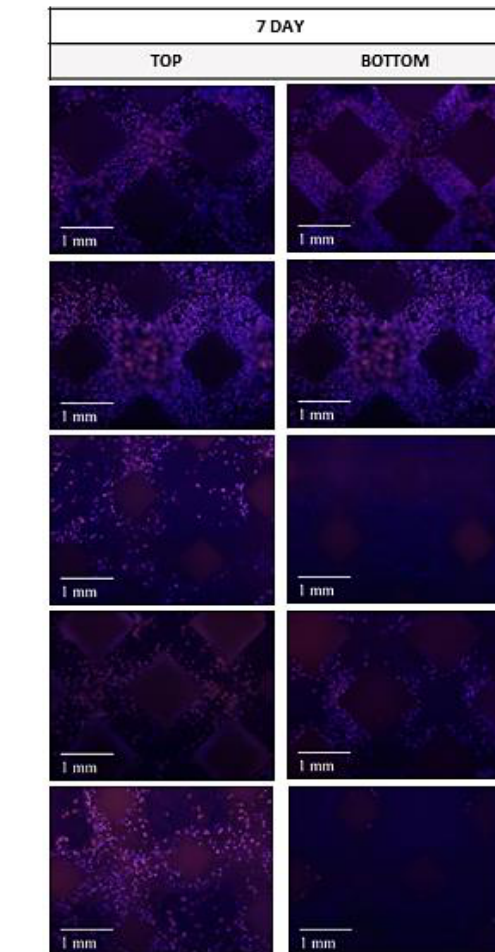
Figure 10. Fluorescence micrographs representing merged Hoechst stained nucleus (blue) and actin cytoskeleton (red) of MC3T3-E1 preosteoblast cells on the uniform and gradient BCC structures after culturing for 4 days and 7 days. Top represents the side where cells were seeded onto the samples.